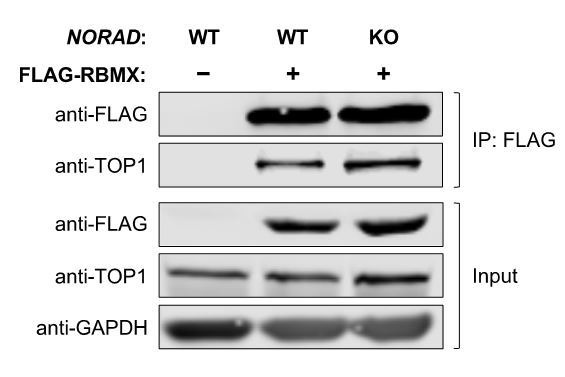
Co-immunoprecipitation of RBMX and TOP1 in NORADwild-type and knockout cells.FLAG-tagged RBMX was stably expressed in HCT116 cells and immunoprecipitated using identical conditions as that described in Munschauer et al., 2018.